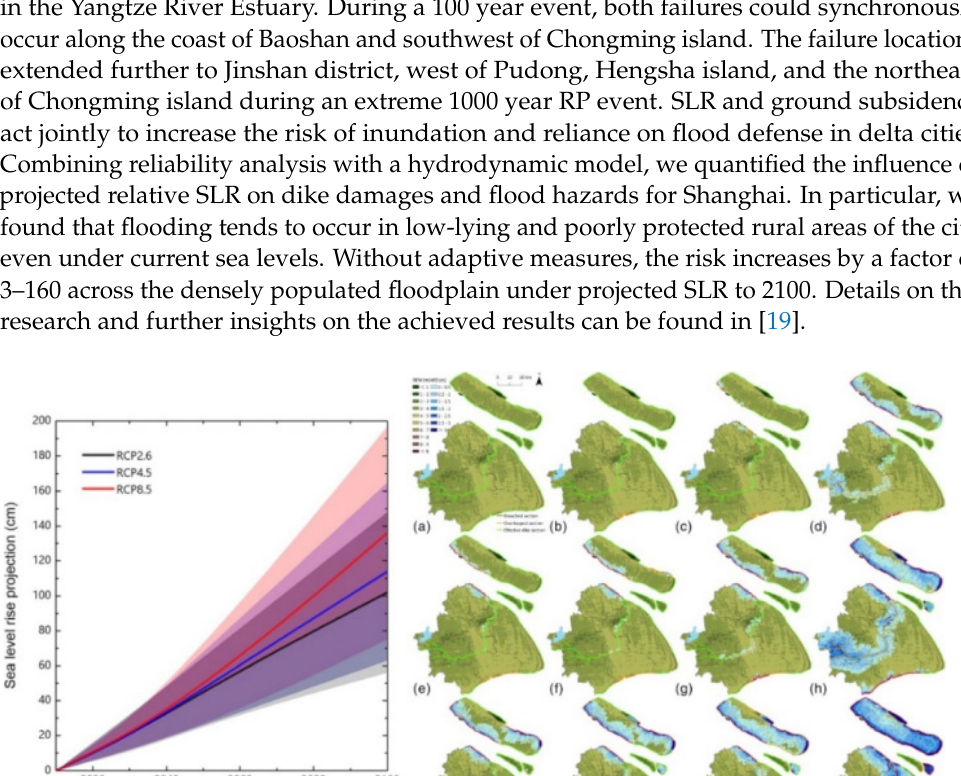
Figure 7. Inundation map for Lingang New City of Shanghai in 2015, 2030, and 2050 under two simulated levee-breach inundation scenarios (100 year and 1000 year) modelled with TanDEM-X DEM and ground subsidence (refer to [18]).